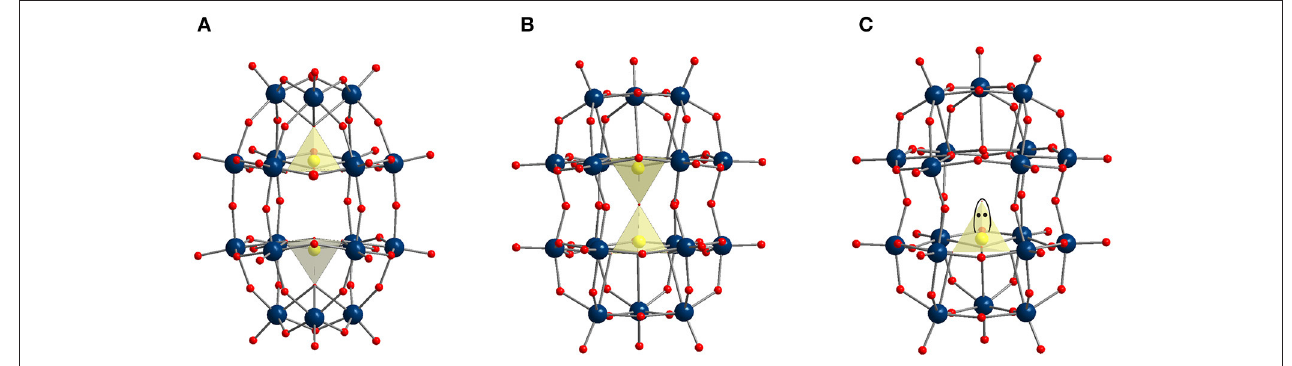
FIGURE 2 | Ball and stick representation of (A) classical Dawson type anion P 2 Mo 6 − 18 (Briand et al., 2002); (B) anion in P 2 O 7 Mo 4 − 18 (Kortz and Pope, 1994); (C) anion in AsW 7 − 18 (Jeannin and Martin-Frere, 1979). Color code: addenda atom Mo (B) or W (C) , dark blue spheres; heteroatom P (B) or As (C) , yellow spheres; O, red spheres.